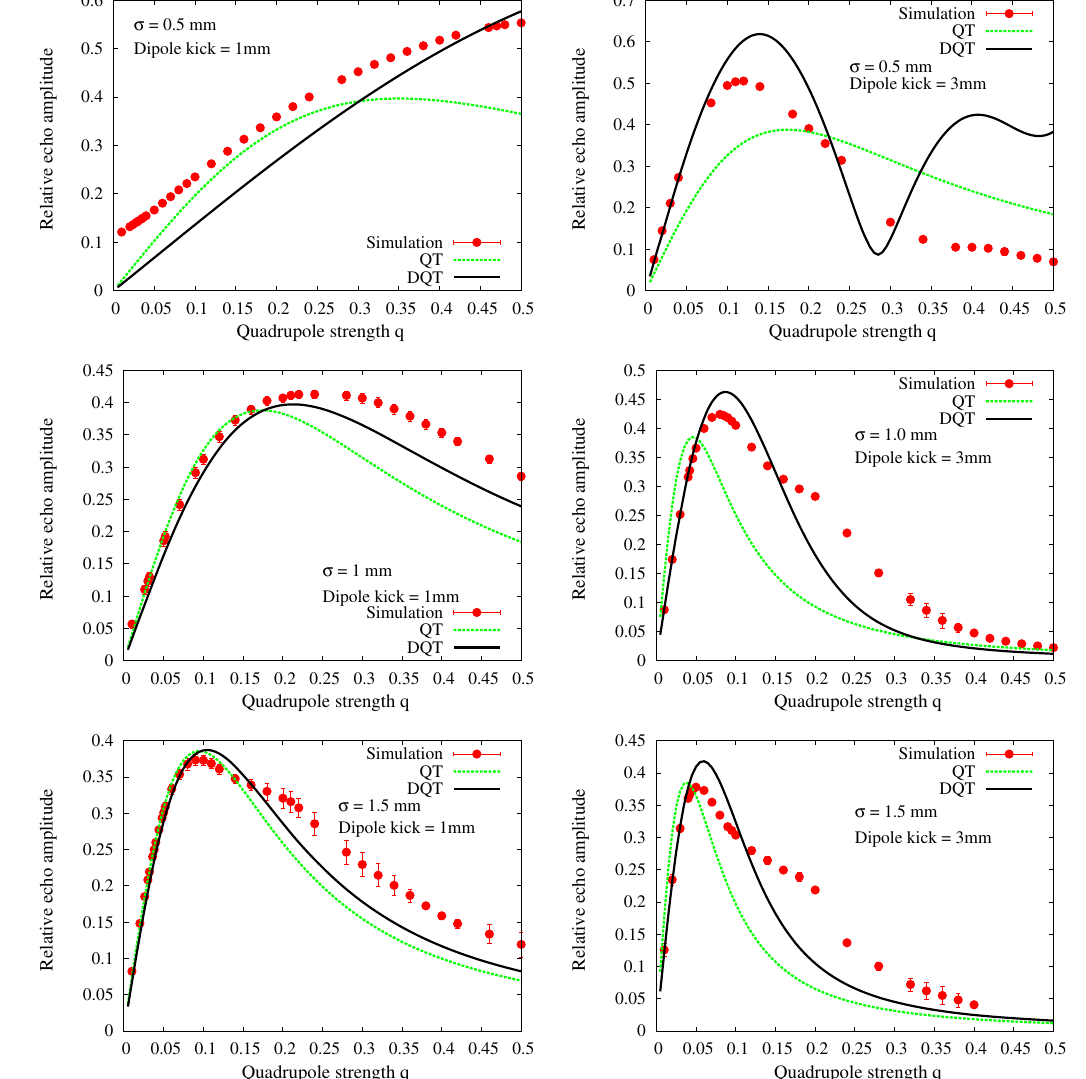
FIG. 5. The relative amplitude of the first echo as a function of the quadrupole strength parameter q . Simulations (red dots) are compared with QT, the nonlinear quadrupole theory (green curve) and DQT, the nonlinear dipole-quadrupole theory (black curve). The initial emittances increase from top to bottom, at each emittance the left plot corresponds to a dipole kick ¼ 1 mm, the right plot to a dipole kick ¼ 3